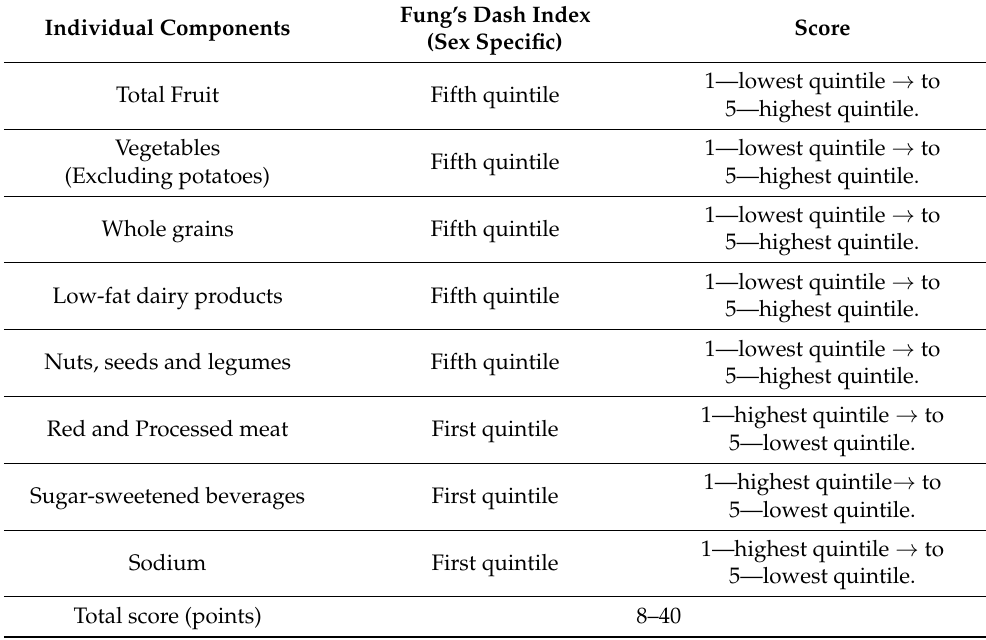
Table 1. Standards for scores on Fung’s DASH diet